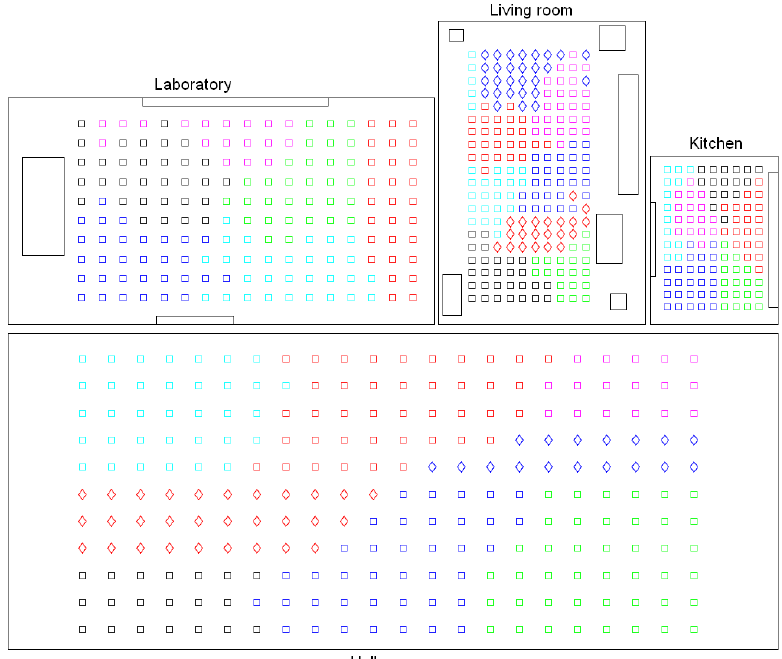
Figure 18. Results of the intermediate-level mapping using CNN and the layer fc7 (4096 components). Bird’s eye view of the four rooms of the Bielefeld set. The colors of the capture points indicate the cluster they belong